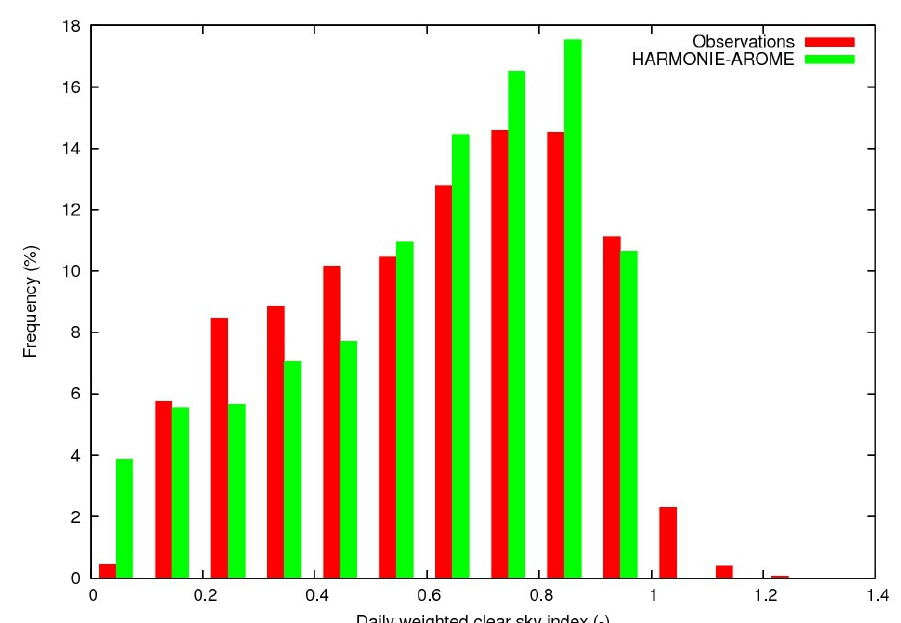
Figure 12. Frequency distribution of daily mean CSI (weighted using hourly SW irradiance) for observations and Danish NEA data (May to December